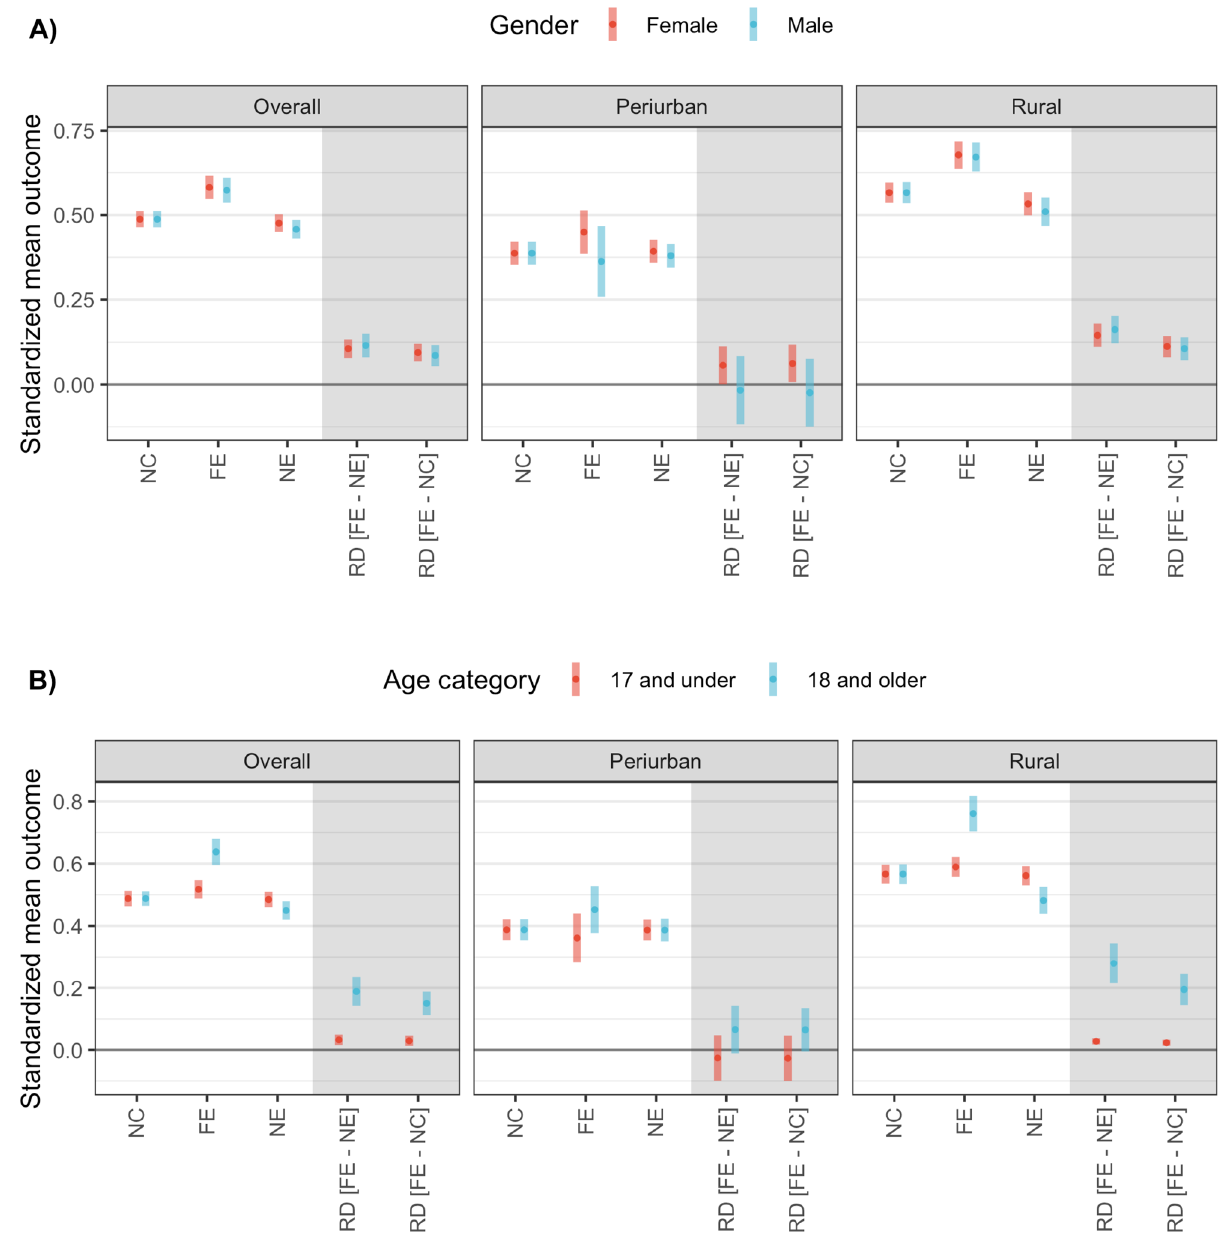
Figure 4. Standardized mean outcome estimated under simulated scenarios by geographic area and ( A ) gender and ( B ) age in the Loreto department in the Peruvian Amazon. Standardized mean outcome estimations for the natural course (NC) and simulated scenarios of full exposure (FE), no exposure (NE) and their risk differences (RD, grey